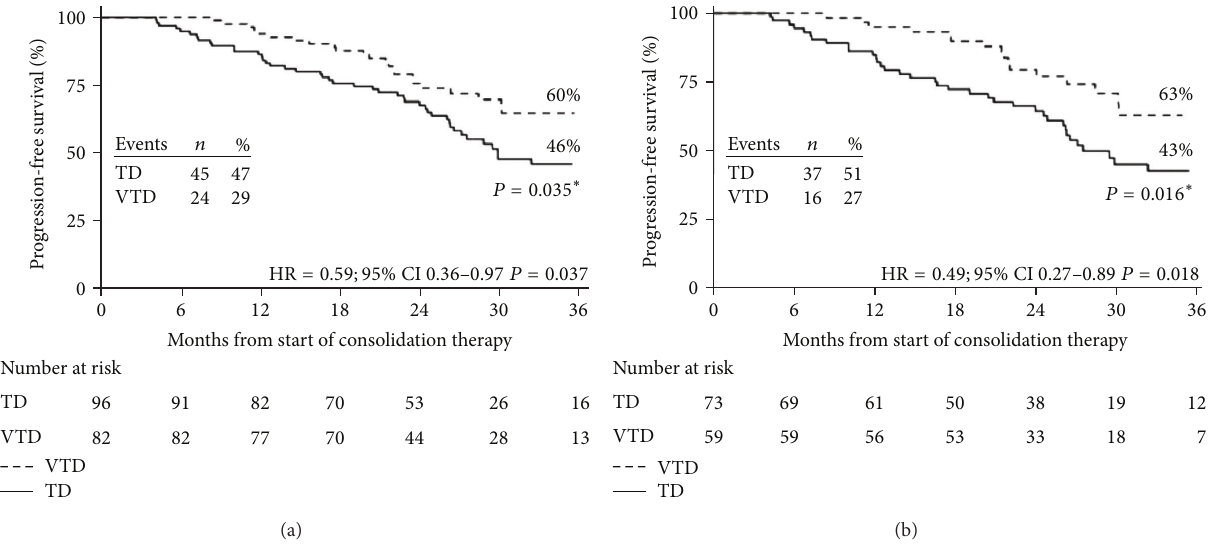
Figure 5: Kaplan-Meier curves for PFS from the landmark of starting consolidation therapy according to the presence or absence of cytogenetic abnormalities. The figure shows PFS for patients with no cytogenetic abnormality or with del(13q) positivity but lack of t(4; 14) and del(17p) or t(4; 14) and/or del(17p) positivity which received VTD consolidation therapy (a) or TD consolidation therapy (b). ∗ 𝑃 value according to log-rank test (adapted from [17]).